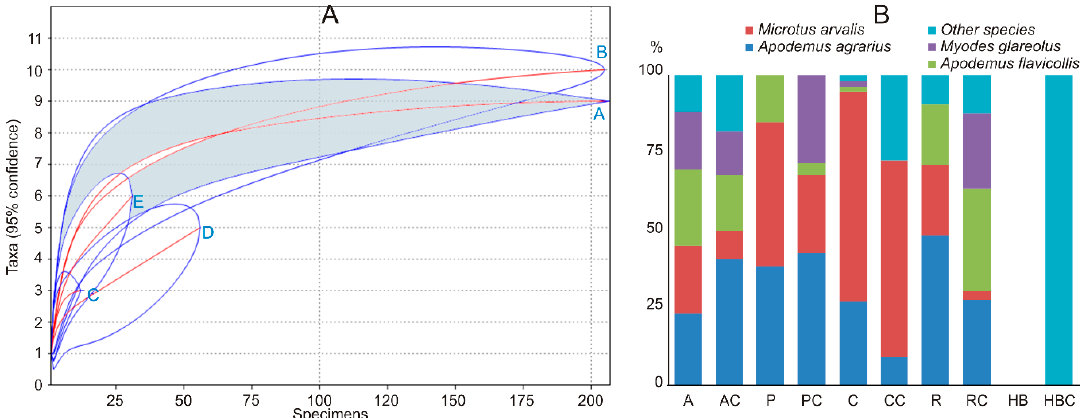
Figure 2. Small mammal species accumulation curves ( A ): A—control, B—apple orchards, C—plum orchards, D—currant plantations, E—raspberry plantations, and share of the dominant species in the control habitats and commercial fruit farms in Lithuania, 2018 ( B ): A—apple orchards,